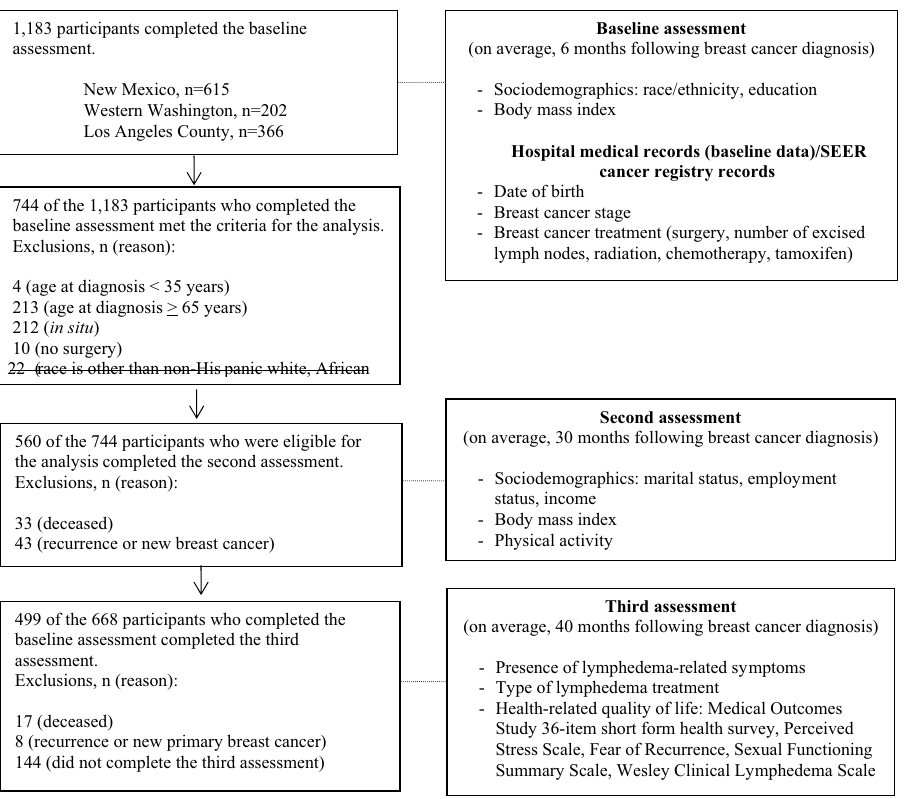
Figure 1. Flowchart describing recruitment flow and data collection. Out of 1183 participants who completed the baseline assessment, 499 were included in this study after